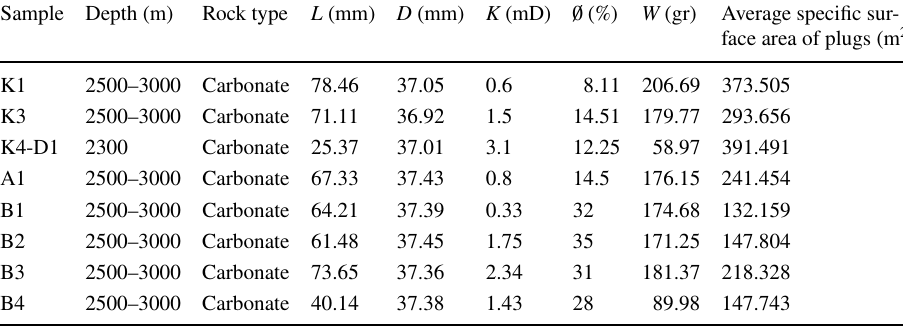
Fig. 6 Carbonate core samples Table 1 Properties of core